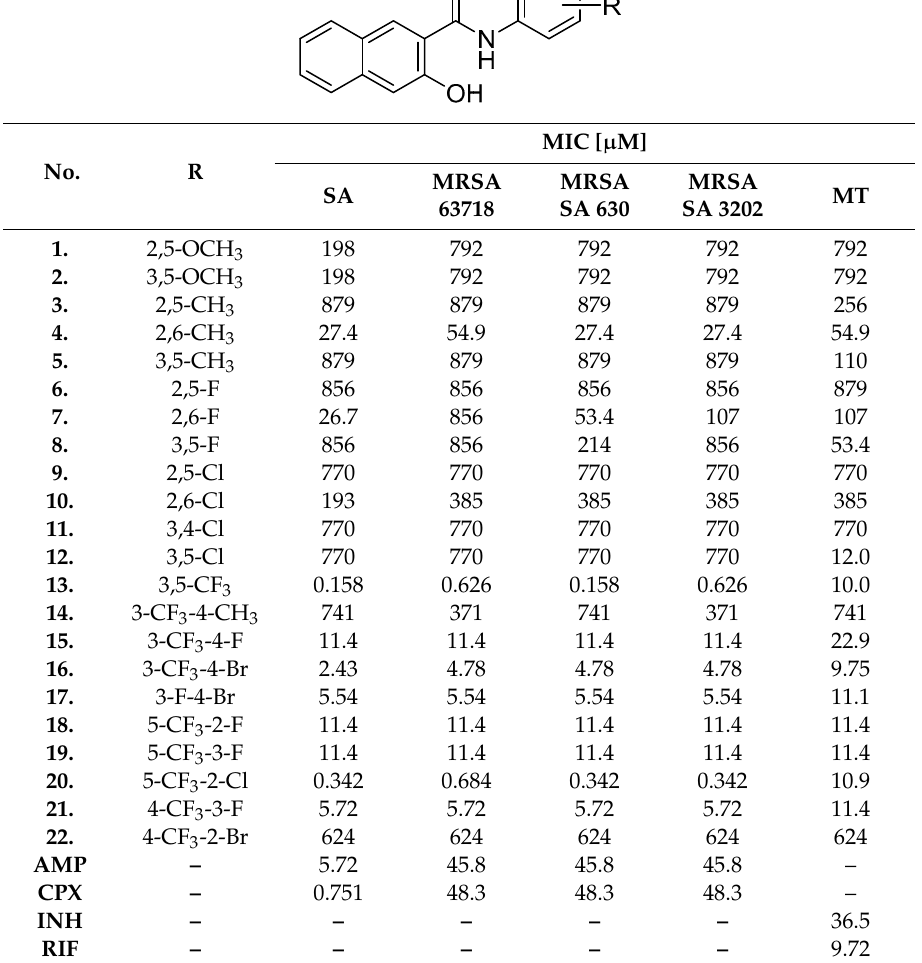
Table 1. Compositions of N -disubstituted 3-hydroxynaphthalene-2-carboxanilides, in vitro antistaphylococcal activities MIC [ µ M] compared to ampicillin (AMP) and ciprofloxacin (CPX), in vitro antitubercular activity MIC [ µ M] compared to isoniazid (INH) and rifampicin (RIF).